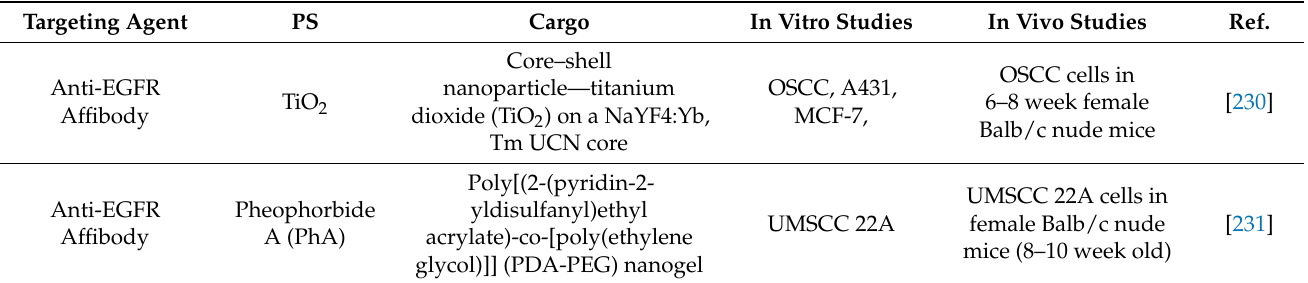
Table 13. EGFR-targeted PDT performed with anti-EGFR affibodies conjugated with carrier molecules. Cargo In Vitro Studies In Vivo Studies